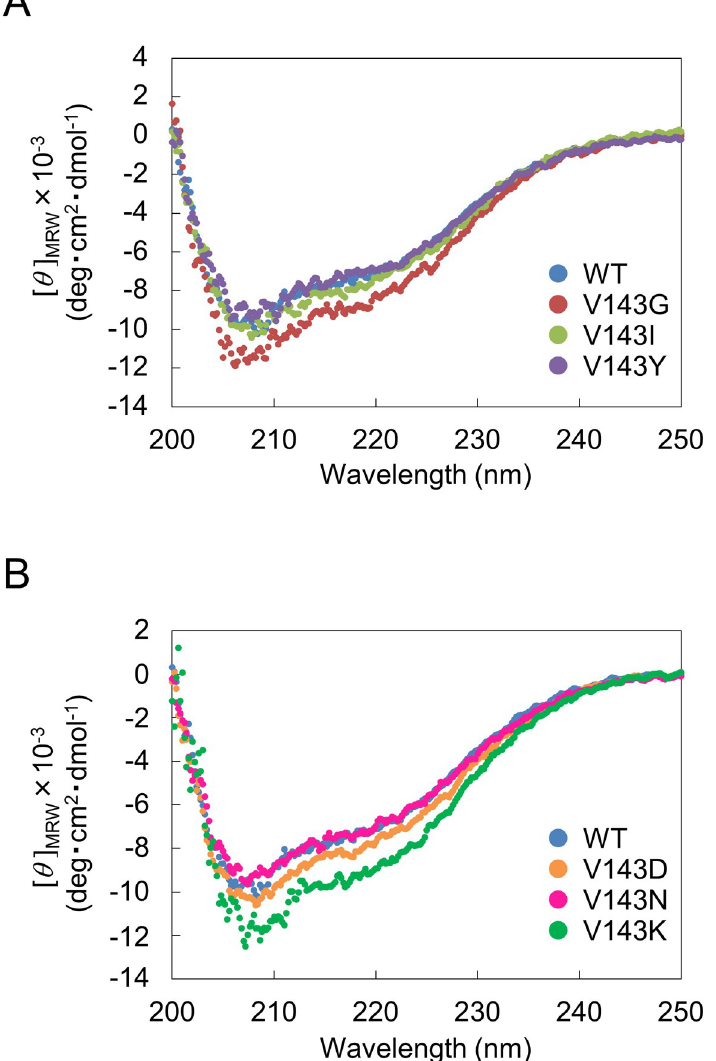
Fig 7. CD spectra of Val143 variants. The spectra at 200–250 nm were measured in 5 mM Tris-HCl buffer (pH 8.3), 20 mM KCl, 5% glycerol at 25˚C with protein concentrations of 1.0 μ M. One of the representative data of duplicate determination is shown. The original data are in S4